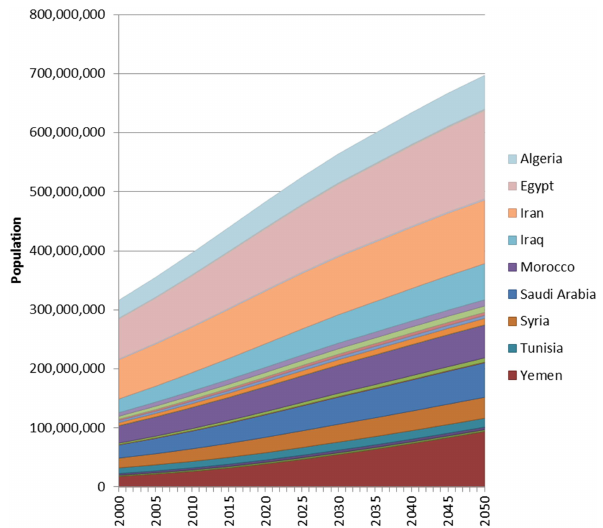
Fig. 3. Projected population in the MENA region for the 22 coun- tries. Only some selected countries are shown in the legend (Source: CIESIN,